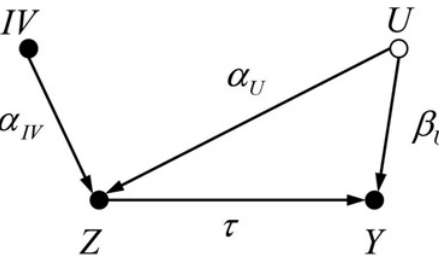
Figure 1: Causal graph with an instrumental variable ( IV ). Z is the treatment, Y the outcome, and U an unobserved confounder (represented by the vacant